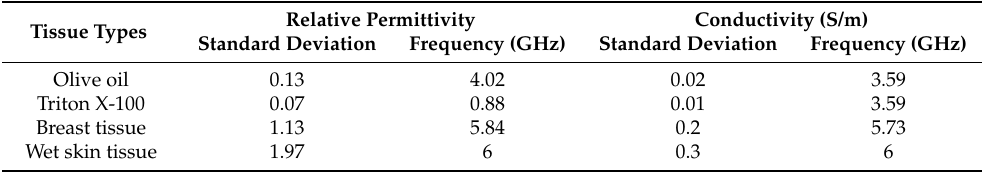
Figure 7. Median of dielectric properties obtained from pure materials olive oil, Triton X-100 and ex vivo rat tissues: ( a ) Relative permittivity and ( b ) conductivity. Table 3. Maximum standard deviation of five measurements over the frequency range of 0.5–6 GHz for pure materials (olive oil, triton X-100, breast and wet